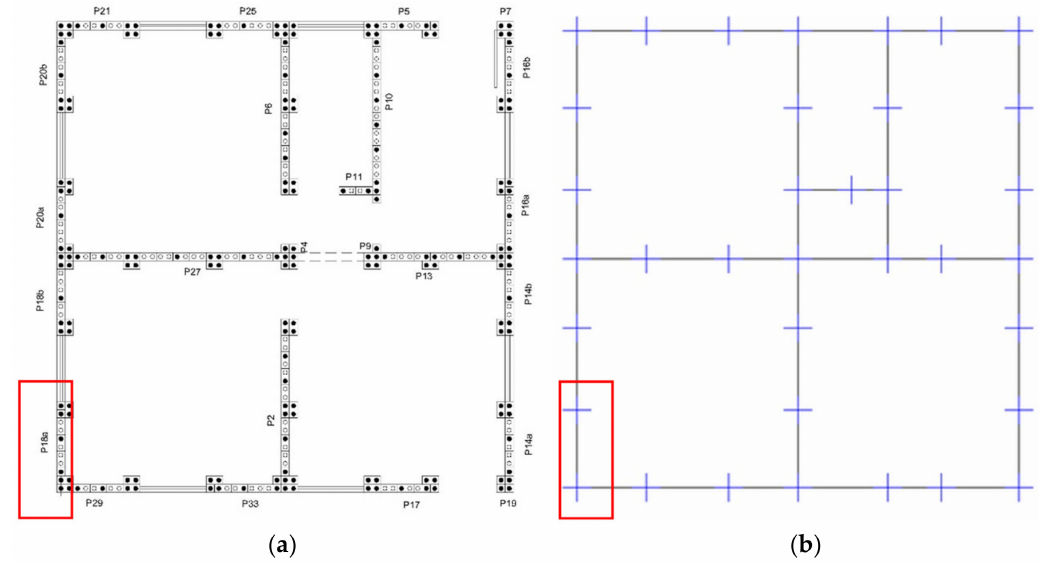
Figure 21. ( a ) Isolated walls used in structural verifications; ( b ) Correspondent computational basis nodes at the columns’ basis